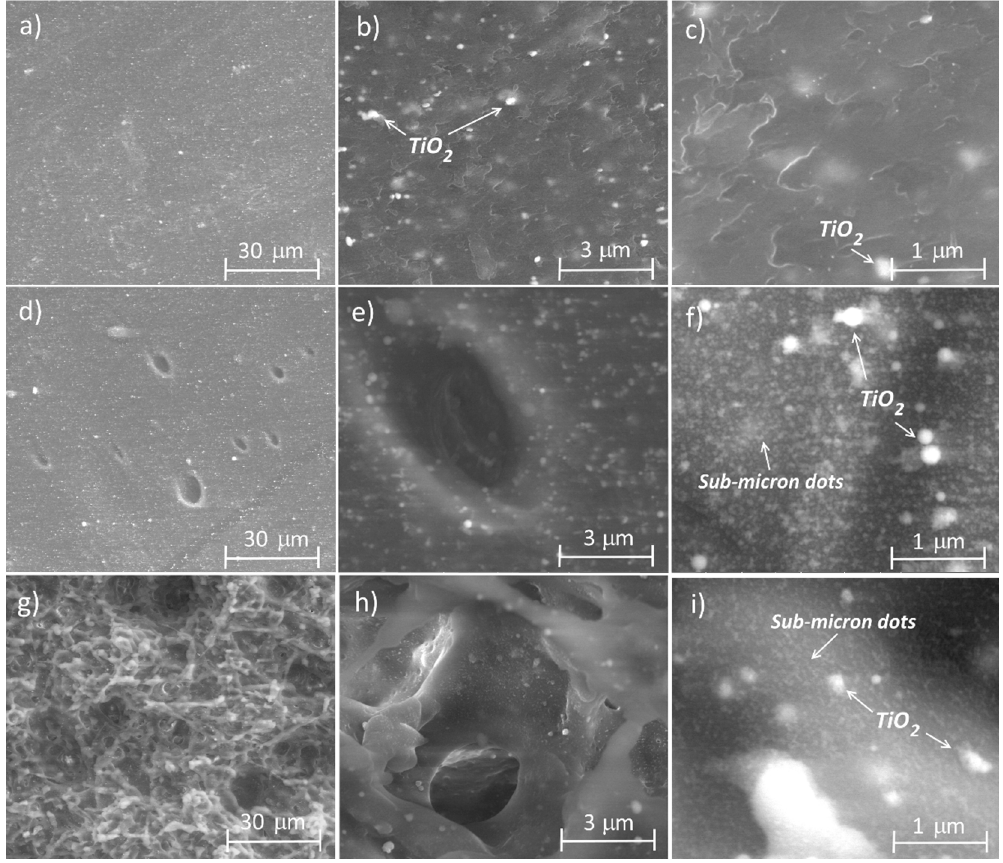
Figure 2 . ESEM images of the ABS surface roughness: ( a – c ) before laser irradiation; ( d – f ) after green laser irradiation in focus; ( g – i ) after green laser irradiation 0.8 mm out of focus. Magnification: ( a ) 2800× scale bar 30 µm; ( b ) 24,000×, scale bar 3 µm; ( c ) 80,000×, scale bar 1 µm.